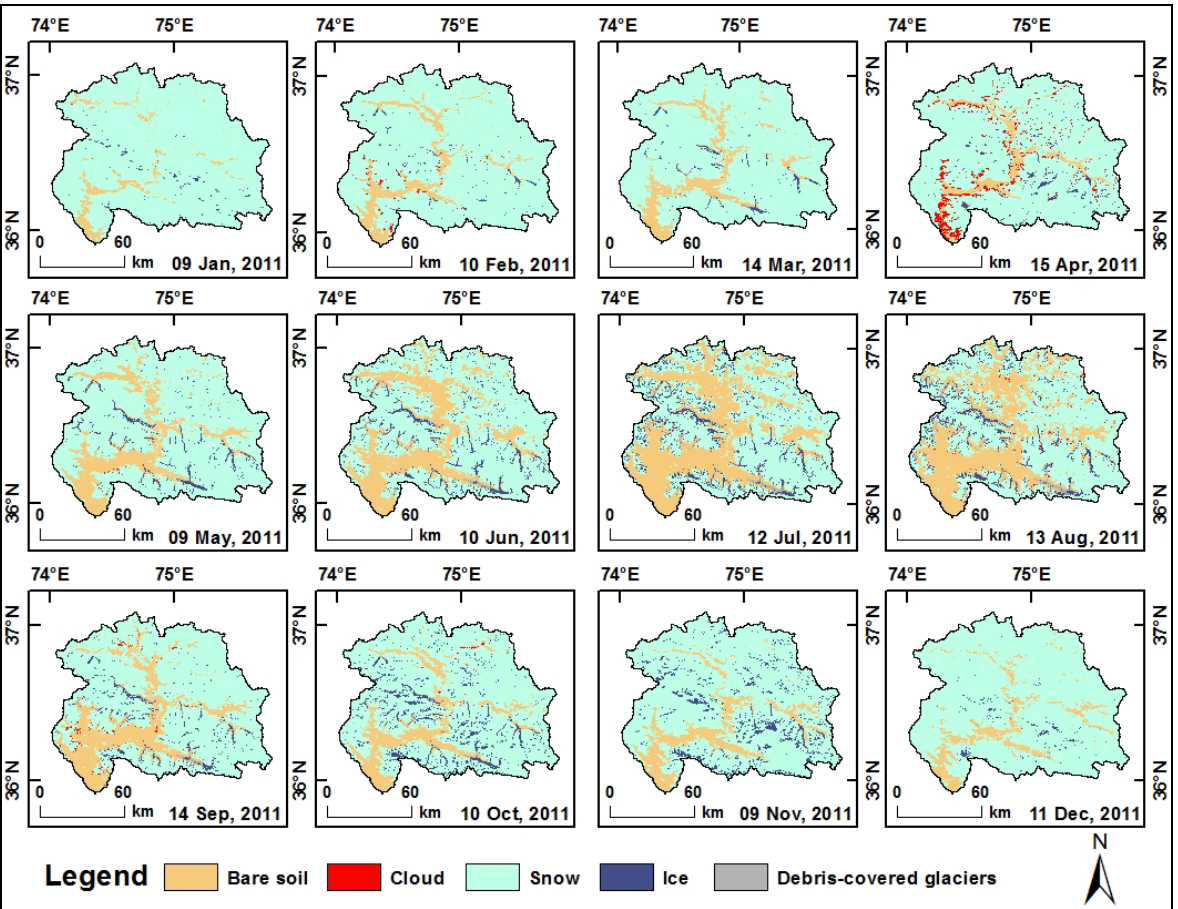
Figure 5. Processed MODIS images for each month from the year 2011 are shown. It is clearly visible that a major part of the ice is exposed during the ablation period (July, August and September) due to the melting of seasonal snow.